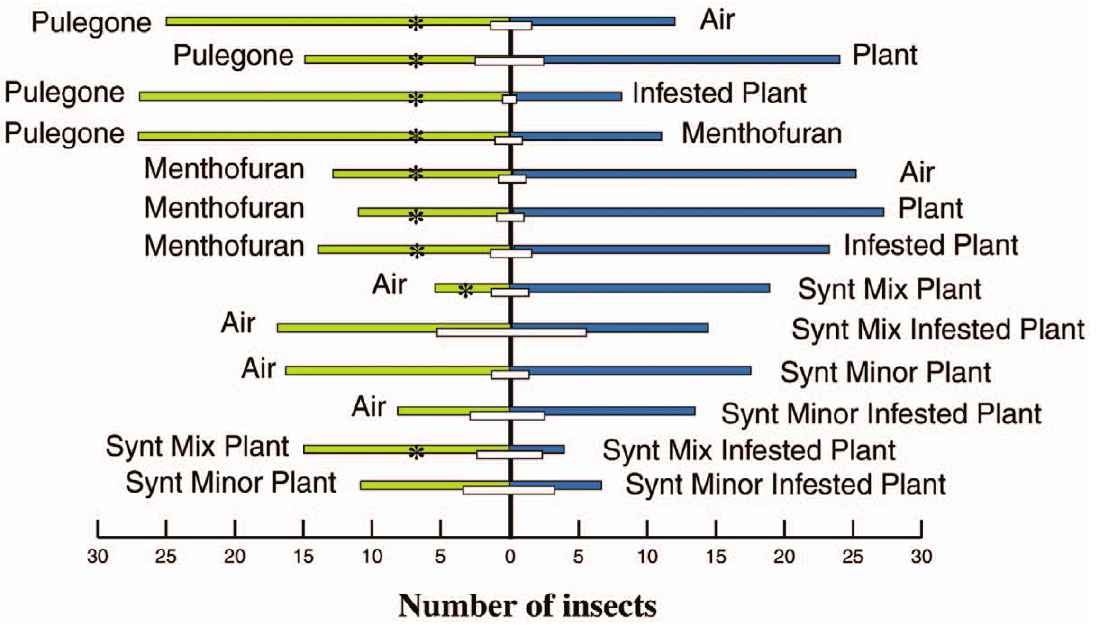
Figure 3. Response of C.herbacea in a Y-tube olfactometer when offered to either Sigma-grade ( + )-pulegone, ( + )-menthofuran, synthetic mixtures of compounds with the same content of typical intact plant emissions (Synt Mix Plant), synthetic mixtures of compounds with the same content of typical infested plant emissions (Synt Mix Infested Plant), synthetic mixtures of only minor compounds with the same content of typical intact plant emissions (Synt Minor Plant), synthetic mixtures of only minor compounds with the same content of typical infested plant emissions (Synt Minor Infested Plant) or GC-grade air. A x 2 test served toevaluate differences from a 50:50 distribution over two olfactometer arms. Insects that did not reach the end of either olfactometer arm within 10 min (NC: no choice) are indicated by white bars. Asterisks indicate significant differences (P , 0.05).